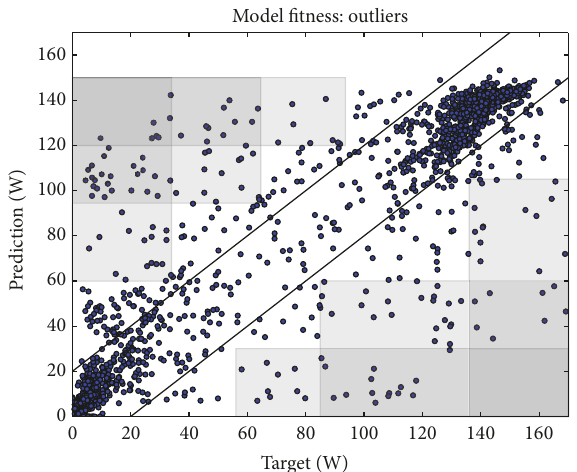
Figure 3: A pie chart of the proportion of predictions in different error categories. Nearly half (47.5%) of all predictions have an error of less than 2